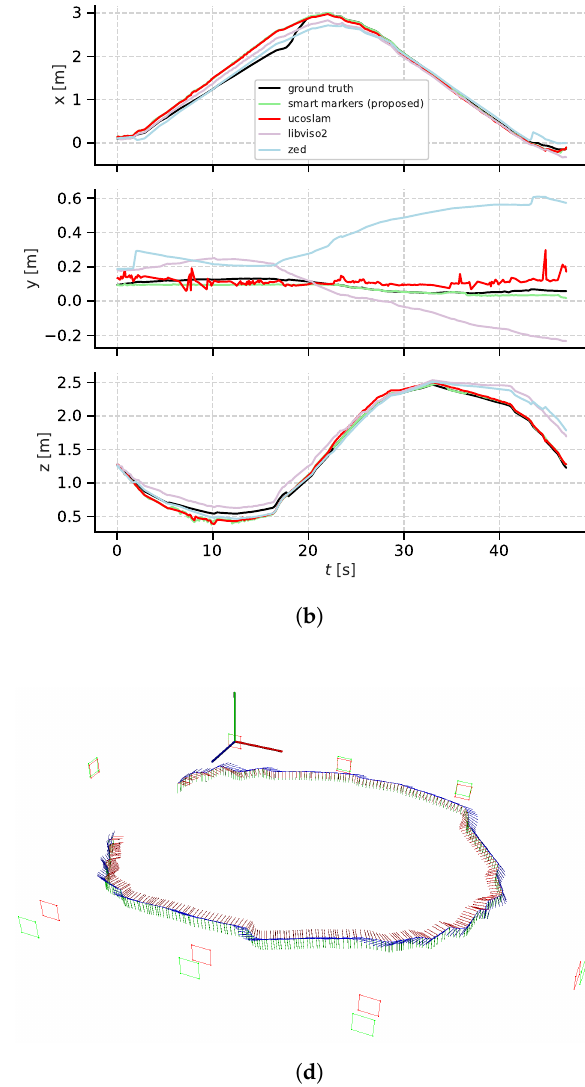
Figure 16. Camera localization evaluation, T-Seq3/hall dataset ( a , c ) and T-Seq4/room dataset ( b , d ). Comparison of camera trajectories ( a , b ) computed with UcoSLAM, LibViso2, ZED tracking API, and our method; and ground truth. In three dimensional views ( c , d ) we show our camera path, in which red squares represent the Marker Mapper markers and green ones are the poses of smart markers as computed by the first stage of our